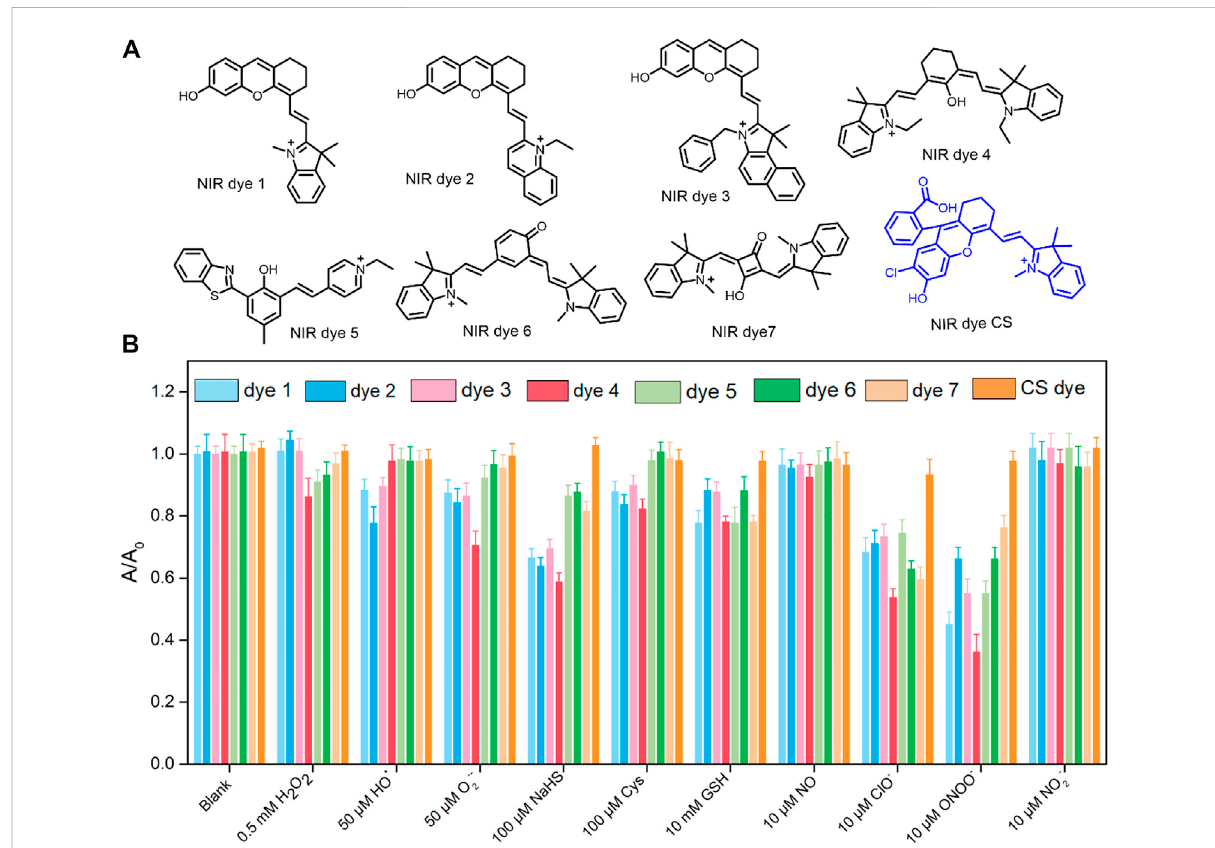
FIGURE 1 (A) Structure of hydroxyl containing NIR dyes 1 – 7 and the CS dye; dyes 1 – 5 were used for the constructed NIR ALP fl uorescent probes. (B) Absorption intensities of the aforementioned dyes (5 μ M) compared to various agents in an aqueous solution (PBS/EtOH = 8/2, pH 7.4).